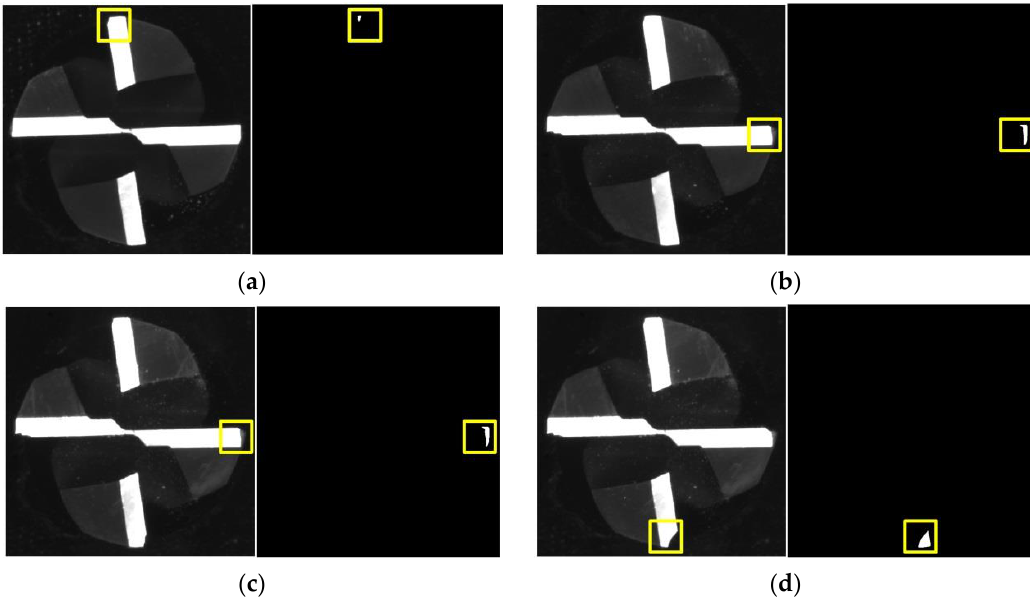
Figure 10. Tool tip status at different time during machining: ( a ) t = 3 h; ( b ) t = 6 h; ( c ) t = 8 h; ( d ) t = 9 h. The original unprocessed images of tool tips and extracted largest failure regions are shown in the left and right parts of the subfigures, respectively.